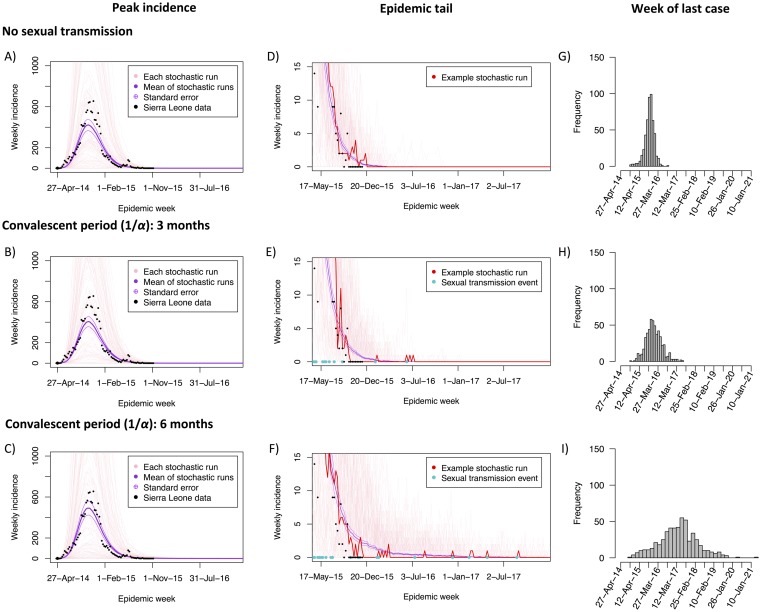
Impact of convalescent period on the tail of the EVD epidemic.Monte Carlo simulations of the weekly incidence of new cases (A, B, C) and the sporadic occurrence of sexual transmission events at the epidemic tail (D, E, F), assuming no sexual transmission (A, D), and sexual transmission with a 3 (B, E) and 6 months (C, F) convalescent period and a per sex act transmission probability fixed at 0.001. Light red lines show the result of 200 simulated trajectories, with corresponding mean (thick purple line) and standard errors (thin purple lines). Black dots denote incident cases in Sierra Leone as reported by the WHO [19]. The dark red lines in (D), (E), and (F) highlight a single representative trajectory, and the blue dots along the horizontal axis indicate a sexual transmission event. Histograms of the day of the last EVD case from 1,000 simulated epidemics in absence of sexual transmission (G) and for a convalescent period of 3 (H) and 6 (I) months.